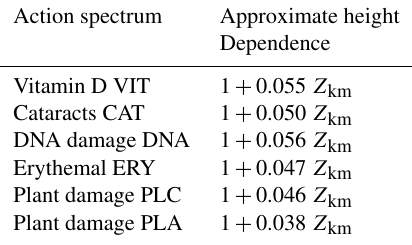
Table A2. Solar zenith angle function G(θ) used in Eq. (A8). G(θ) = g + hθ + iθ 2 + jθ 3 + kθ 4 .